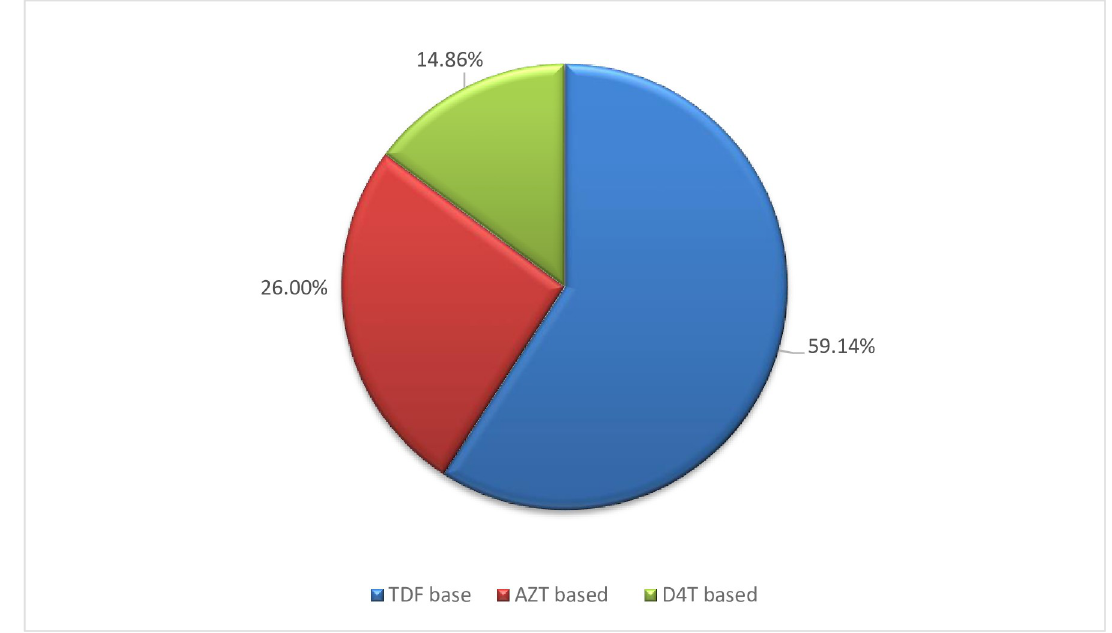
Fig 3. Base line NRTI based art of patients taking ART drugs at ART at public health facilities in South West Shoa Zone,